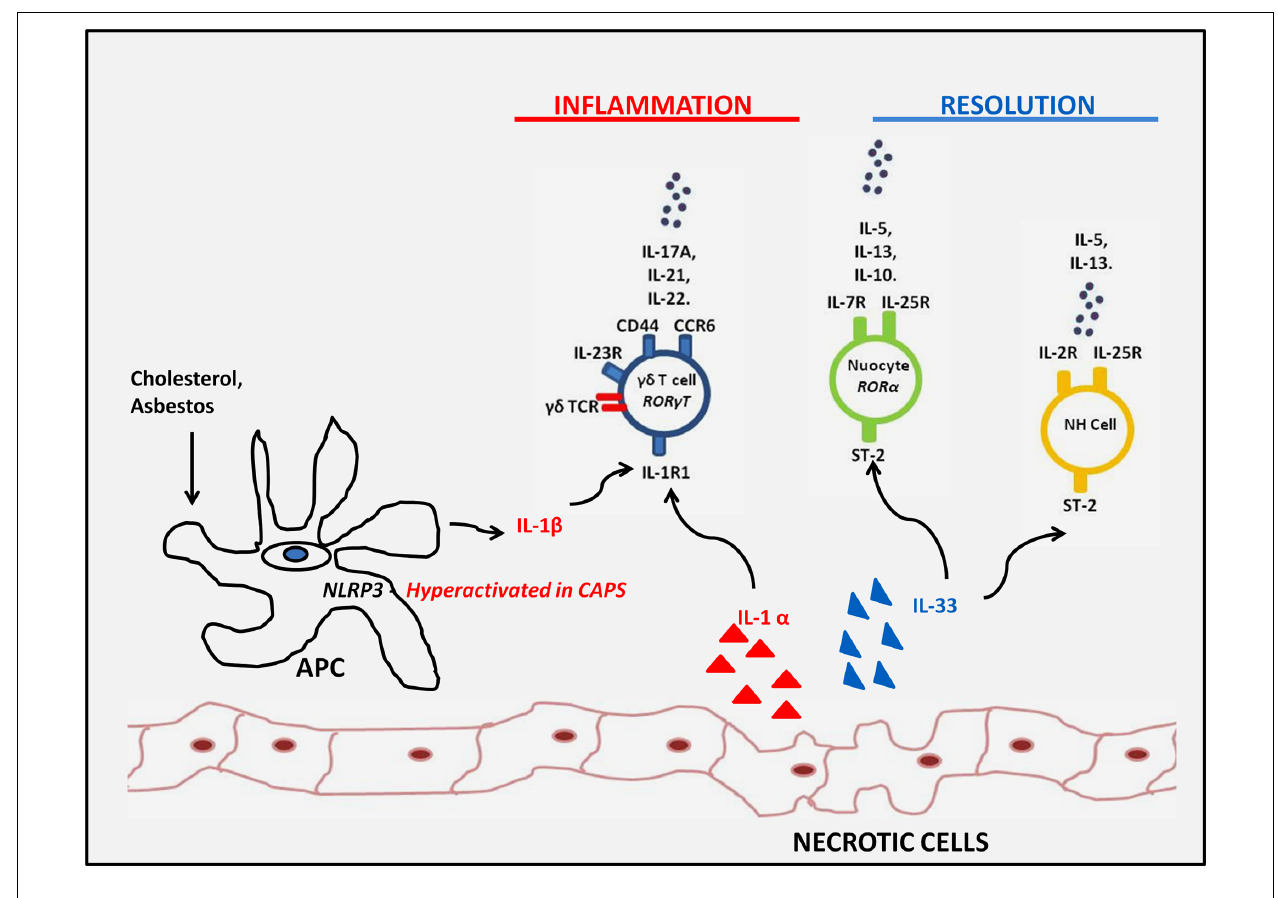
contribute to sterile inflammation or IL-22 which can promote tissue regeneration. On the other hand, IL-33 exposed upon tissue damage, drives type 2 innate responses by nuocytes and NH cells which can have a proresolving influence and dampen sterile inflammatory responses observed in obesity and atherosclerotic